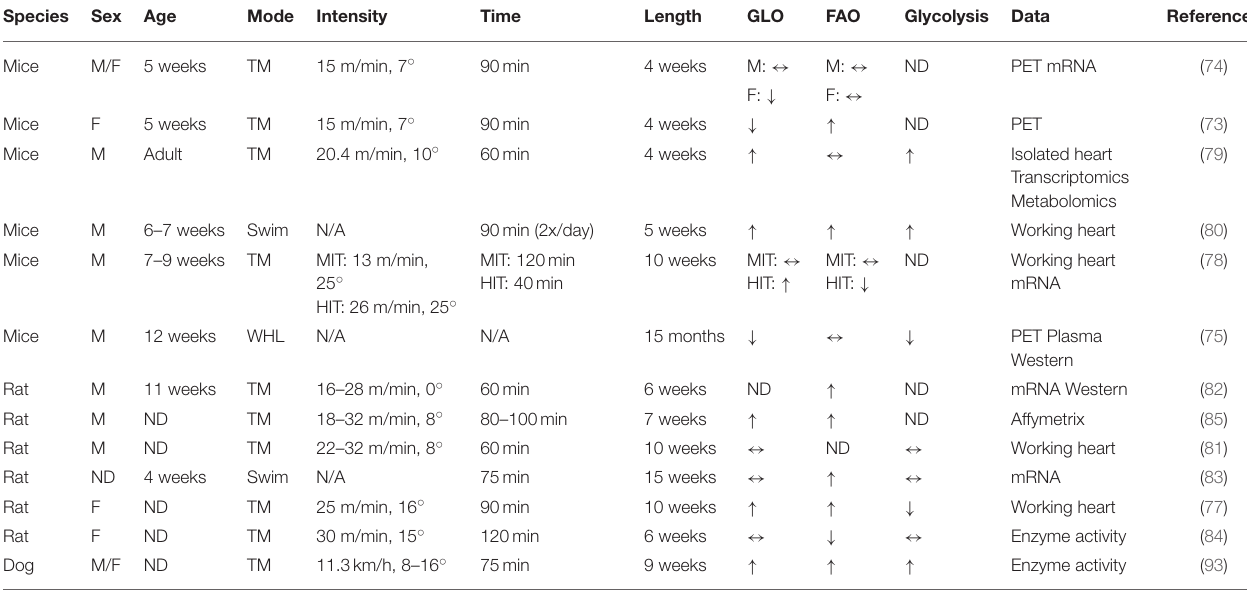
TABLE 1 | Cardio-metabolic effects of chronic exercise training in healthy animals. Species Sex